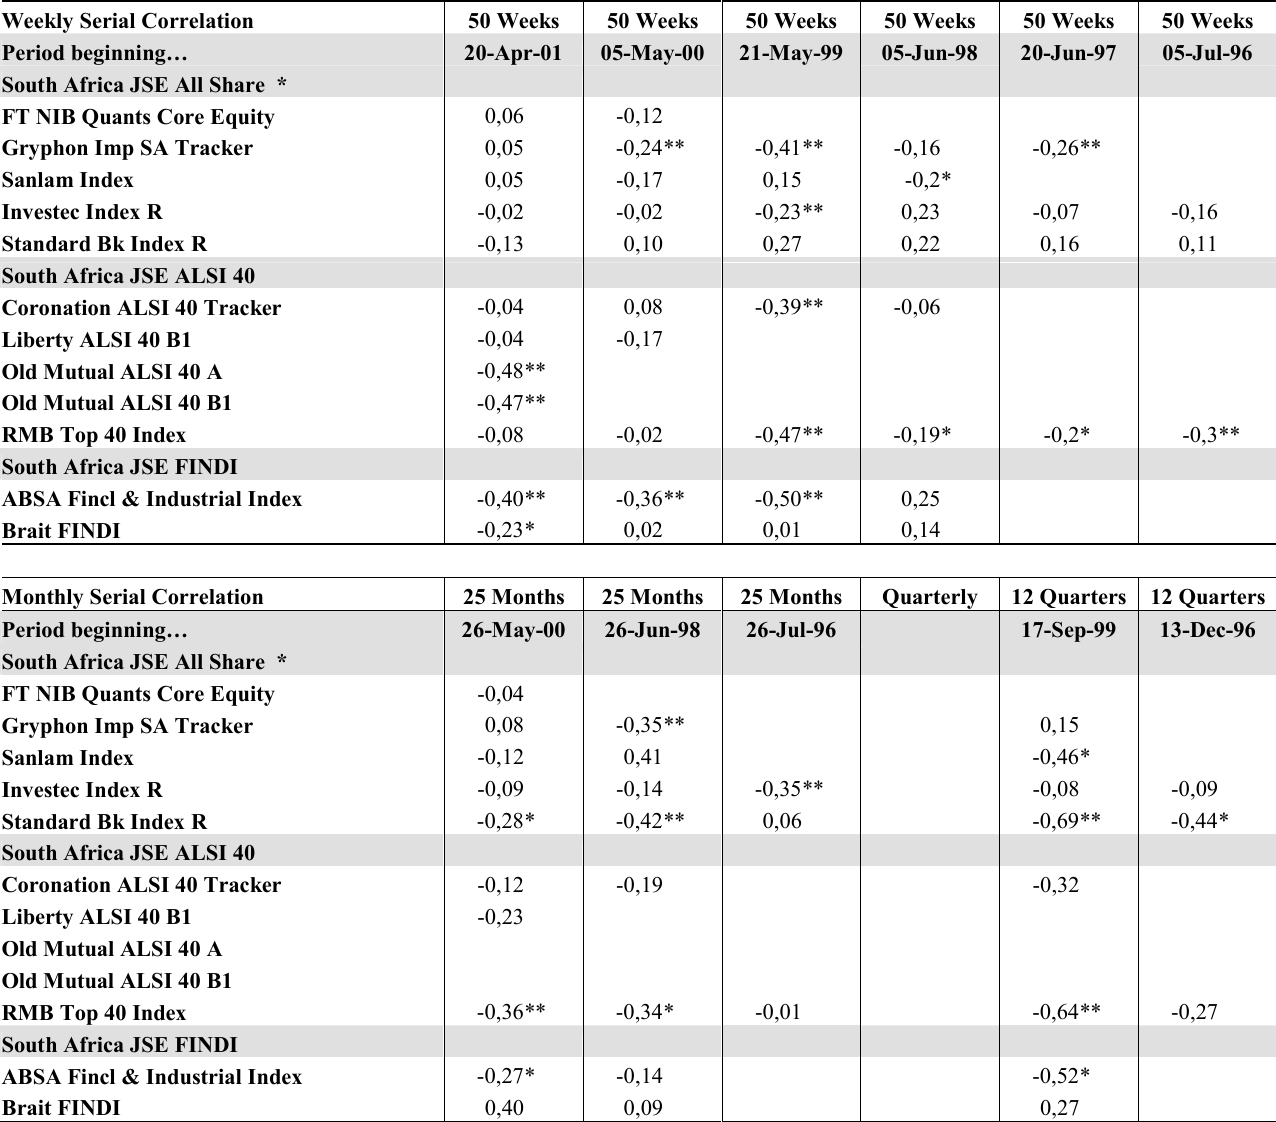
Table 1: Serial Correlation (lag = 1) of each Fund’s TE against its Benchmark for non-overlapping periods Weekly Serial